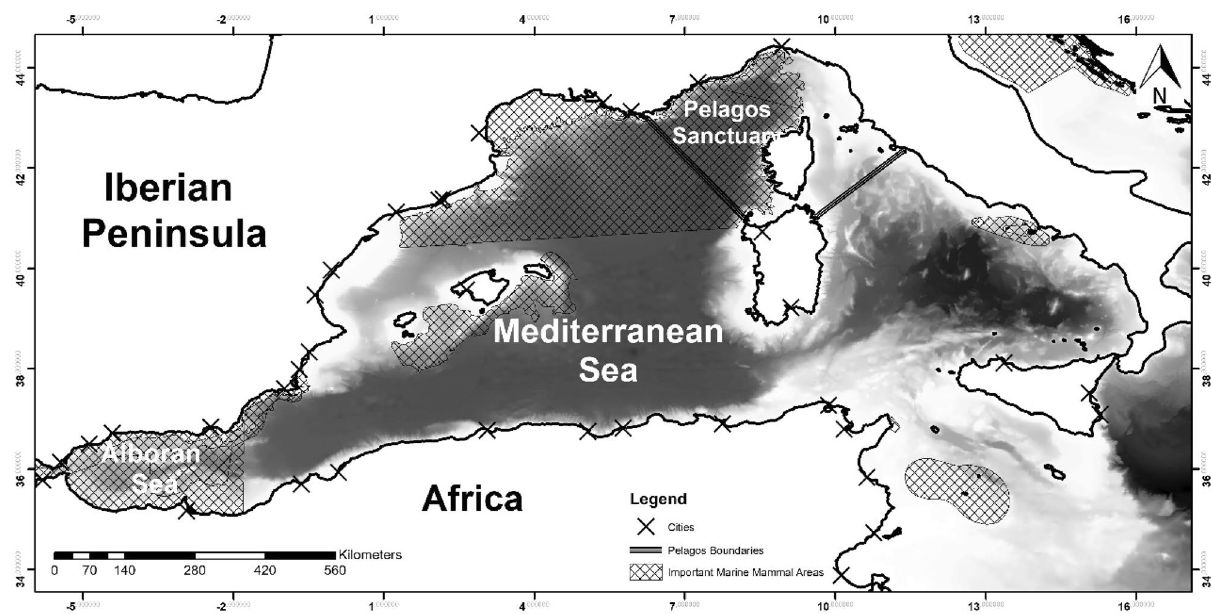
Figure 3. Study area and location of the main cities and Important Marine Mammal Areas. Maps were generated using ArcGIS 10.6 (source: Esri, DigitalGlobe, GeoEye, Earthstar. Geographics, CNES/Airbus, DS, USDO, USGS, AeroGRID, IGN, and the GIS User Community: www. esri.